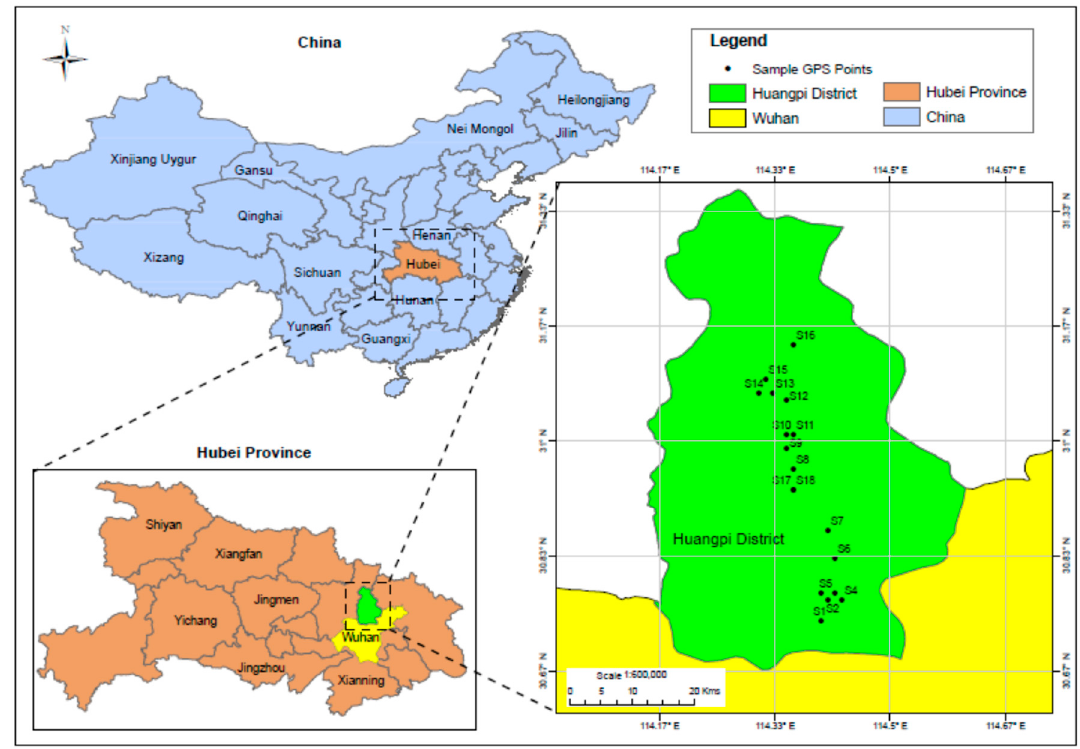
Figure 1. Map of the study area and sampling locations. Note: S1 (Tangjiawan), S2 (Fengdouhu) S3 (Erpaiqu), S4 (Changdi), S5 (Zhujiashan), S6 (Tujiadun), S7 (Zhulinyuan). S8 (Zhoujiawan), S9 (Lishuwan), S10 (Xinyang), S11 (Leqianwan), S12 (Bomogang), S13 (Hanjiafan), S14 (Wanjiatian), S15 (Hongguanshanxiawan), S16 (Dujiatian), S17 (Tianjiaxiaowan), S18 (Tianjiaxiaowan).